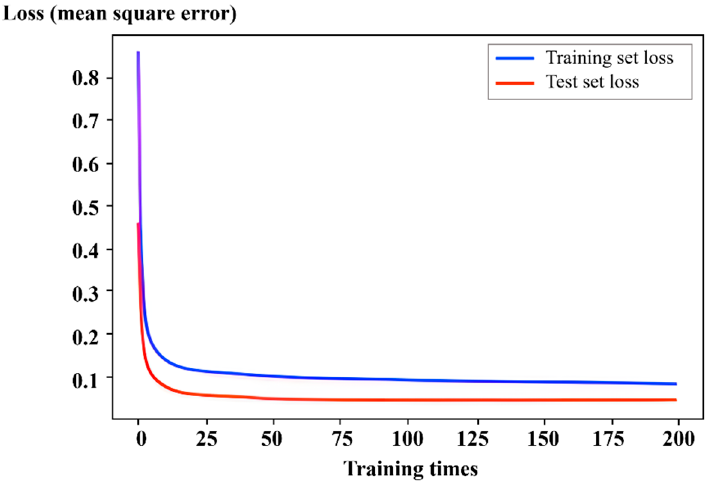
Figure 11. Change in the loss function for time-frequency feature prediction.